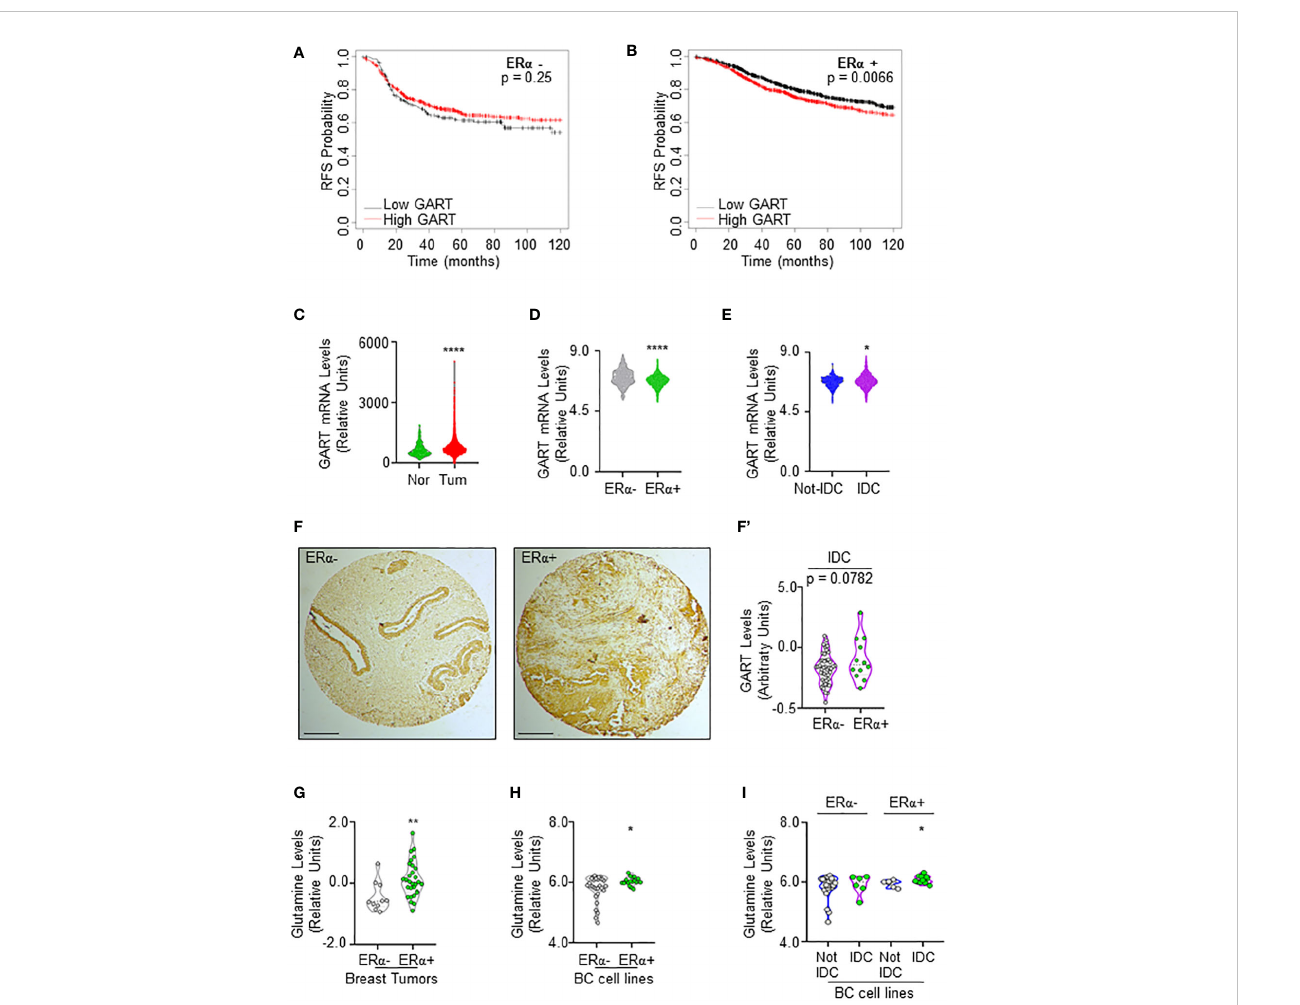
FIGURE 2 GART and glutamine levels in breast cancer. (A) Kaplan-Meier plots showing the relapse-free survival (RFS) probability in women carrying breast tumors expressing either ER a -negative (A) or ER a -positive (B) BC as a function of GART mRNA levels. Data have been downloaded by the website (https://kmplot.com/analysis/). All possible cutoff values between the lower and upper quartiles are automatically computed ( i.e. , auto-select best cutoff on the website), and the best performing threshold is used as a cutoff (35). Signi fi cant differences between the RFS are given as p -value in each panel. (B) GART mRNA levels in breast tumors versus normal breast epithelium as downloaded by TNM plot (https://tnmplot.com/analysis/) database (36). **** ( p < 0.0001) indicates signi fi cant differences as calculated by the Student t-test. GART mRNA levels in BC as a function of ER a expression (D) or the histological type of the tumor (E) downloaded by the cBioPortal (https://www.cbioportal.org/) database. IDC: invasive ductal carcinoma. Not-IDC: other kinds of tumors. Each dot represents one tumor. **** ( p < 0.0001) indicates signi fi cant differences as calculated by the Student t-test. GART immunohistochemical analysis in tissue slides (F) and relative quantitation (F ’ ) in invasive ductal carcinomas (IDC) strati fi ed as ER a -negative and ER a -positive. p-value for differences is given in the panel. Dots represent the number of the analyzed tumors. (G) Glutamine levels in different breast tumors as downloaded by the Breast Cancer landscape (https://www.breastcancerlandscape.org/) (7) and strati fi ed both as ER a - negative or ER a -positive. ** ( p < 0.01) indicates signi fi cant differences as calculated by the Student t-test. Each dot of the plots in (G) represents the value of the indicated parameter in a single breast tumor. Glutamine levels in different BC cell lines as downloaded by the DepMap portal (https:// depmap.org/portal) and strati fi ed both as ER a -negative or ER a -positive (H) and as invasive ductal carcinoma (IDC) or not (Not-IDC) cell lines classi fi ed as ER a -negative or ER a -positive (I) . * ( p < 0.05) indicates signi fi cant differences as calculated by the Student t-test. Each dot of the plots in (H, I) represents the value of the indicated parameter in a single breast cancer cell